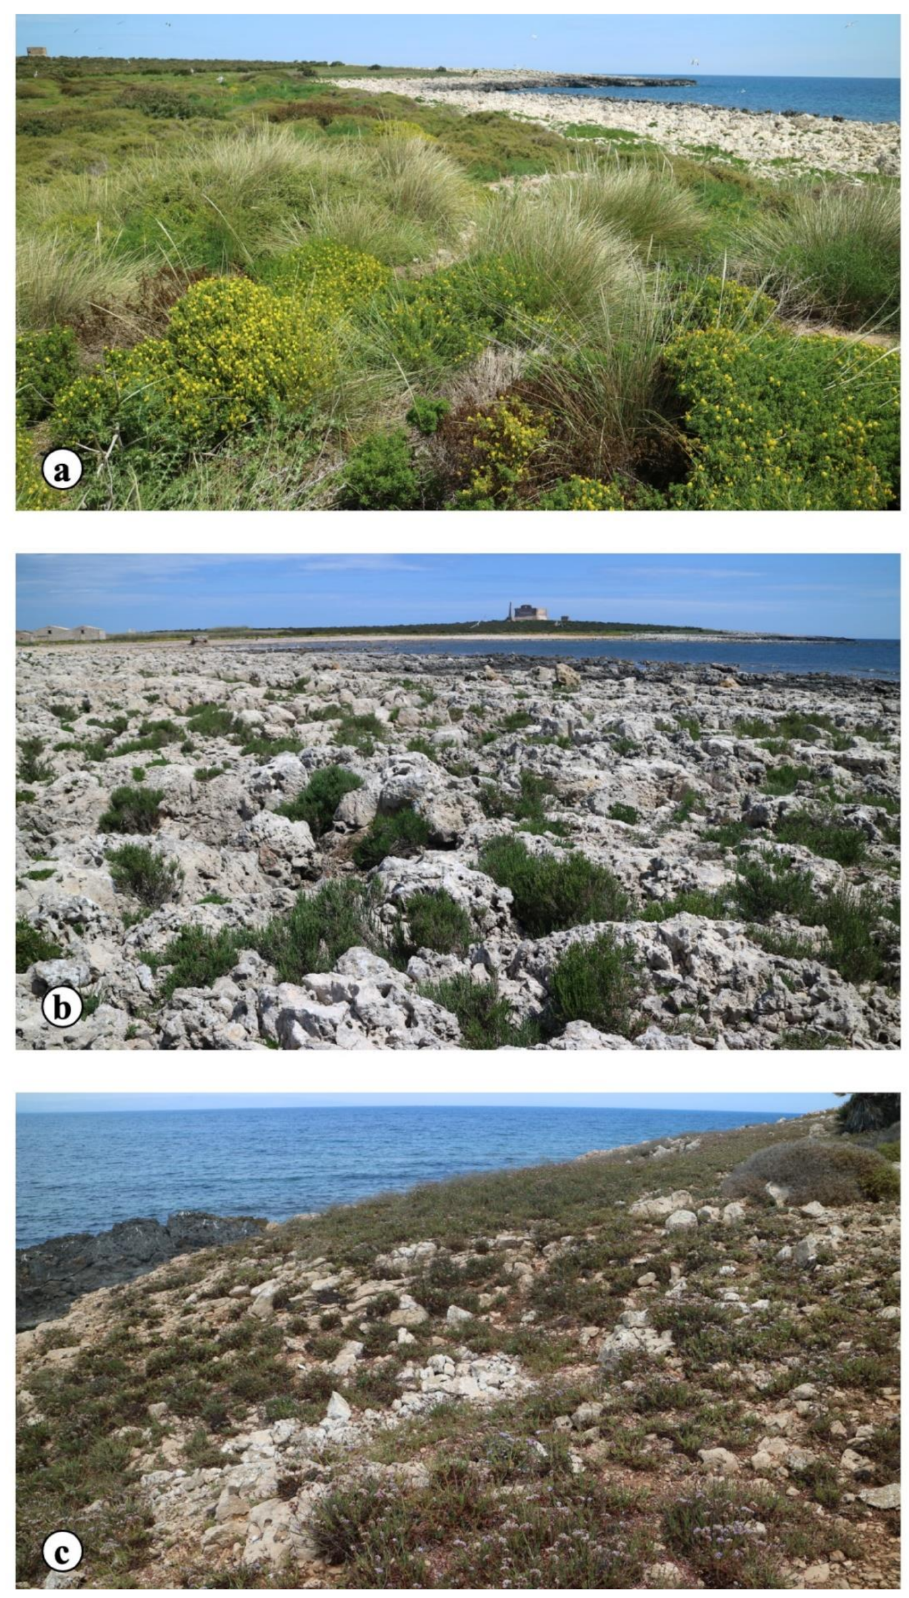
Figure A2. Photo plate illustrating different habitat types on the Island of Capo Passero: ( a ) last strips of vegetation with Calamagrostis arundinacea ( Medicagini marinae-Ammophiletum australis ) mixed with Ononis ramosissima ; ( b ) rocky coast vegetation ( Limonio virgati-Arthrocnemetum macrostachyi ); ( c ) Rocky coast vegetation ( Limonietum hyblaei, Crithmo maritimi-Limonietum virgati